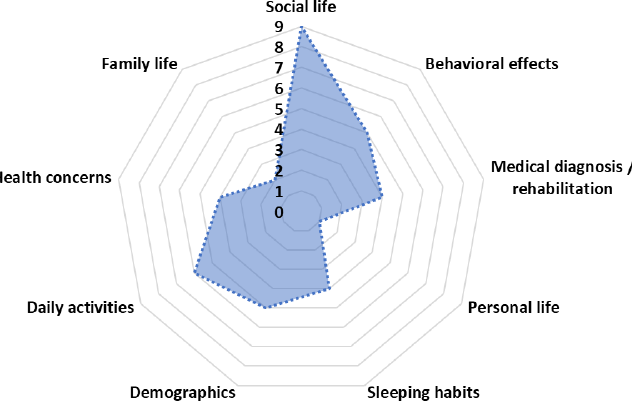
Figure 5. Spider plot of the number of features that belong to each feature category for the first 40 features where the best performance was achieved.